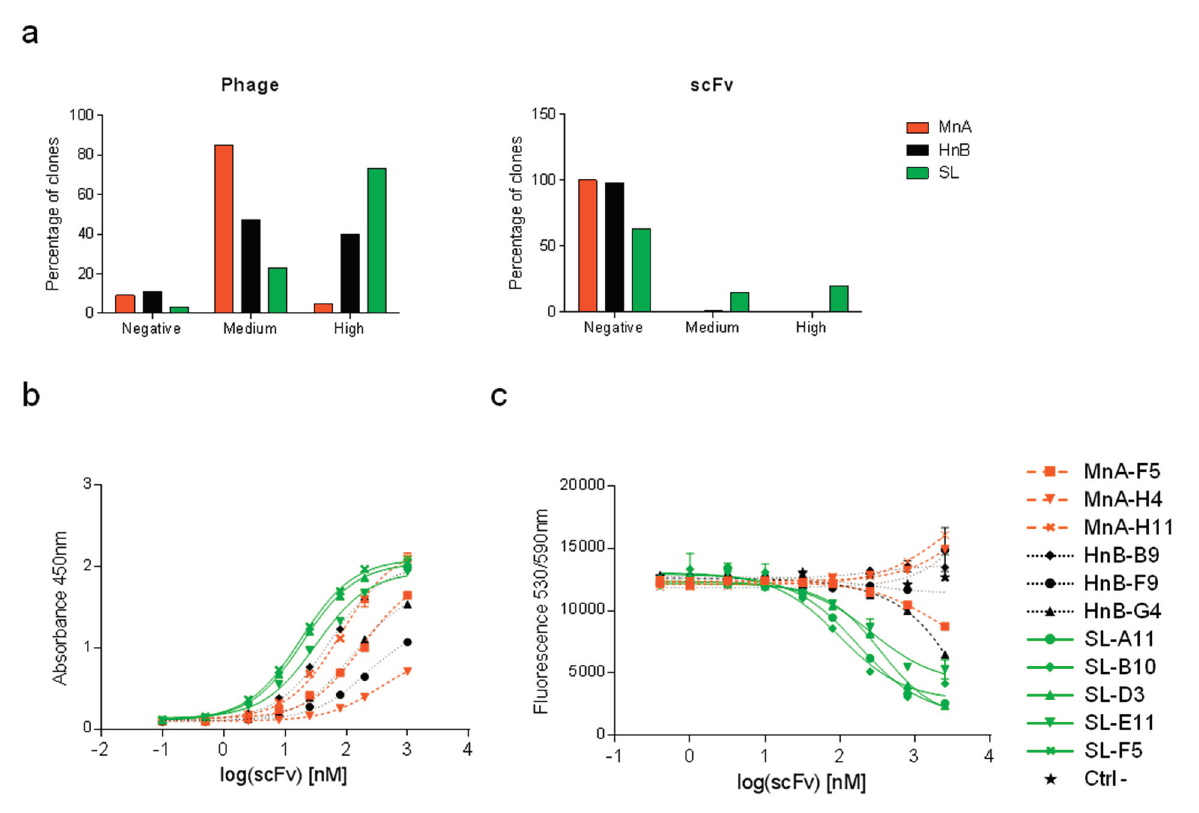
Figure 3. Results of selections against HRP. ( a ) Left panel: for each library (the synthetic long library SL, the human naïve library HnB and the mouse naïve library MnA), 528 clones were expressed at the surface of the phage and tested. A commercial anti-HRP antibody was used as a positive control. Clones which displayed absorbance above 70% of the positive control signal were defined as ‘high’, clones between 10% and 70% as ‘medium’ and clones below 10% as ‘negative’. Right panel: for each library, 88 clones were tested in scFv format. Clones with absorbance above 10% of the signal given by a positive control were classified as ‘high’, clones between 5% and 10% as ‘medium’, and clones below 5% as ‘negative’ (same control as the one used for the screening in the phage format). Clones were also tested for binding to streptavidin and did not show any signal (data not shown). Purified scFvs were tested in dose-response for their capacity ( b ) to bind to HRP by ELISA and ( c ) to block the enzymatic activity of HRP. A negative control scFv was also included. Data are presented as the mean of duplicates ±